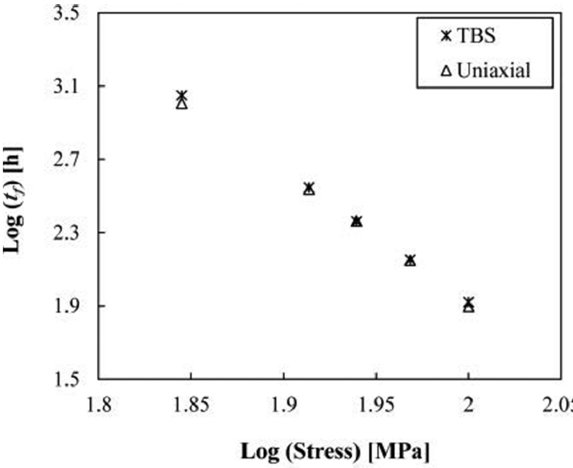
Figure 18: Creep rupture data obtained from TBS and uniaxial speci- mens for grade P91 steel at 650 ° C.